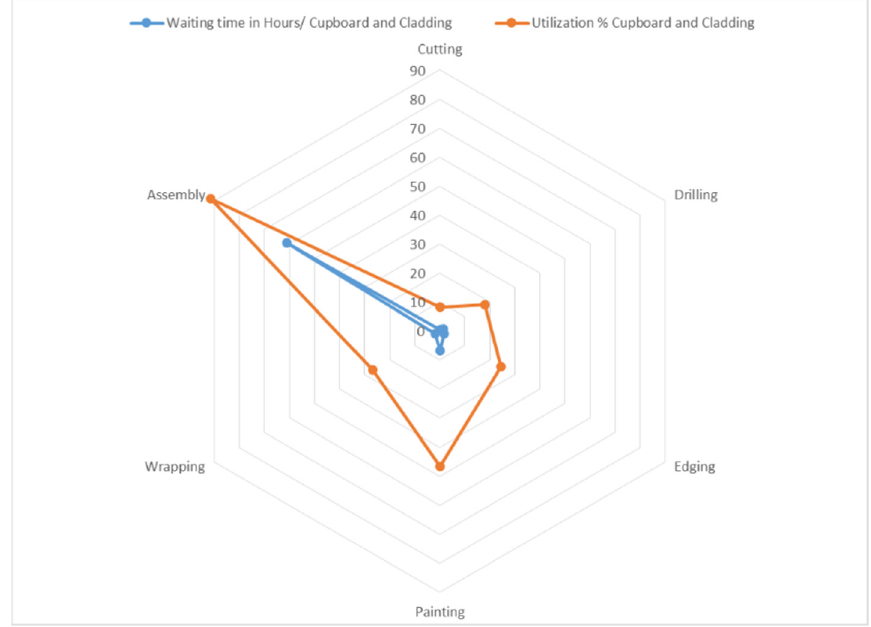
Figure 3. Cupboard/Cladding Radar Chart. Figure 3. Cupboard / Cladding Radar